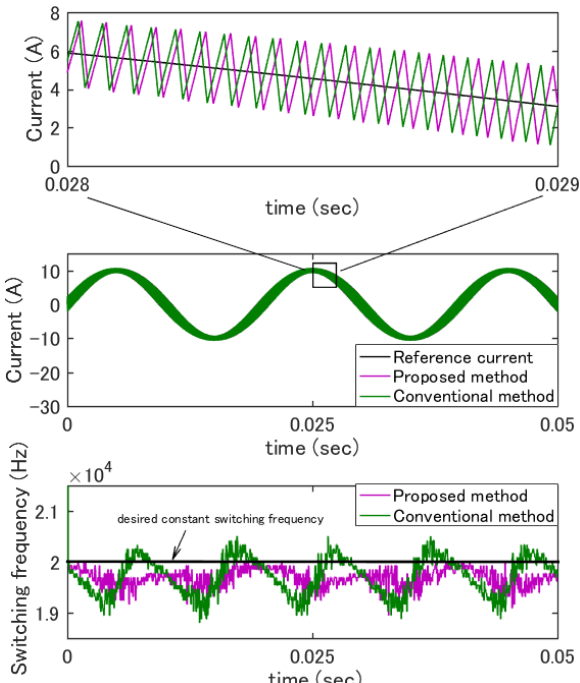
Figure 9. Current and switching period of the proposed method and conventional method for the desired switching frequency at 40 kHz.